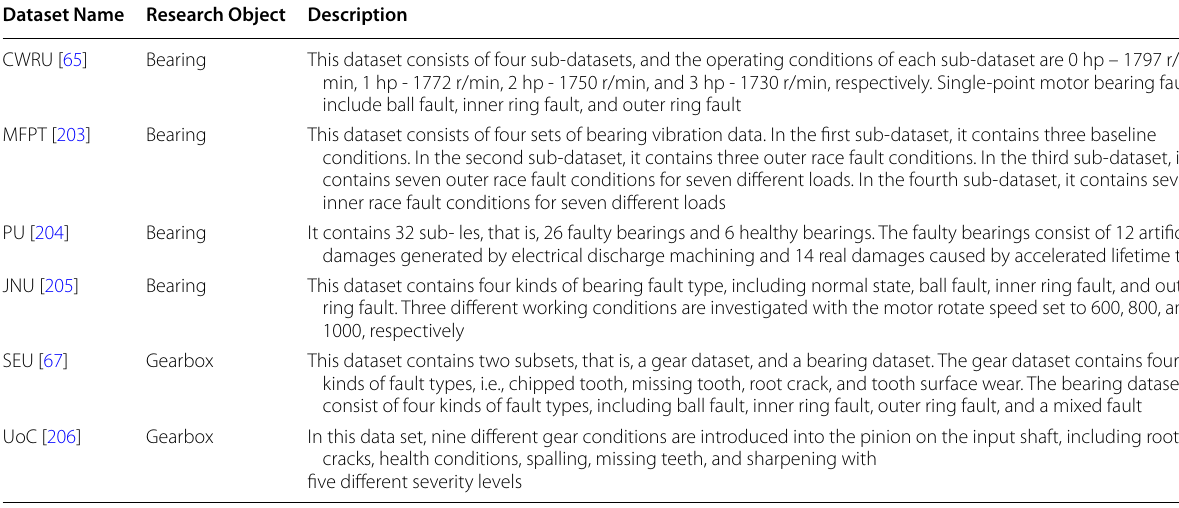
Table 3 Publications about the application of CNN in fault diagnosis Dataset Name Research Object